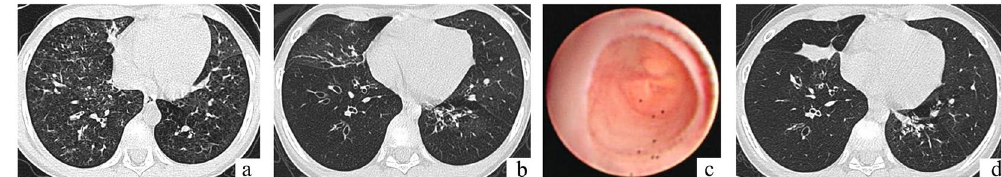
Figure 2. Representative HRCT and Bronchoscopy findings of a patient with severe disease. ( a ) HRCT showing inflammatory bronchiolitis. ( b ) HRCT showing mosaic patterns as well as marked bronchiectasis. ( c ) Bronchoscopy showing a completely occluded lumen in segmental bronchi. ( d ) HRCT showing BO after 4 years of